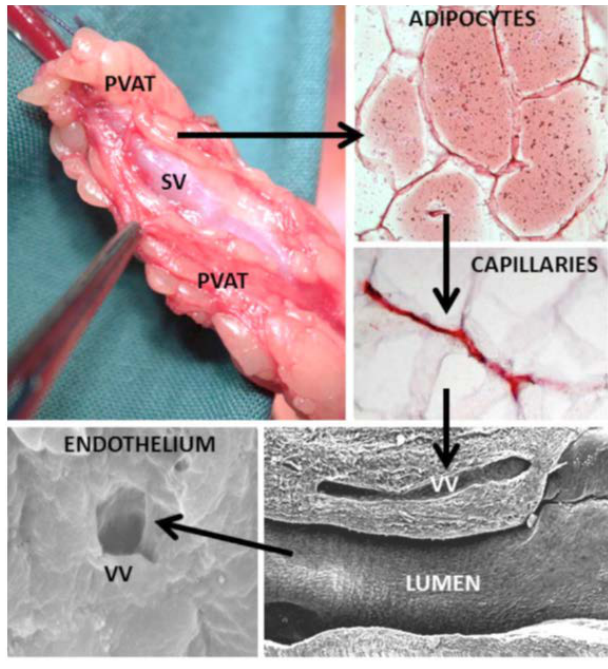
Fig. 4 - Potential transport of perivascular fat-derived factors in no-touch (NT) saphenous vein (SV). Top left: A length of NT SV harvested for coronary artery bypass grafting with perivascular adipose tissue (PVAT) intact. Top right: PVAT adipocytes exhibiting positive immunostaining (red) for endothelial nitric oxide synthase. Below is the capillary network within PVAT. Lower right: Longitudinal scanning electron microscopic image of vasa vasorum (VV) terminating close to the vein lumen. Lower left: Scanning electron microscope image of an aperture/termination of VV at the luminal endothelium. Arrows indicate possible transport from PVAT via the media to the vessel lumen, which may be bi-directional. (From Fernandez-Alfonso et al. [13]